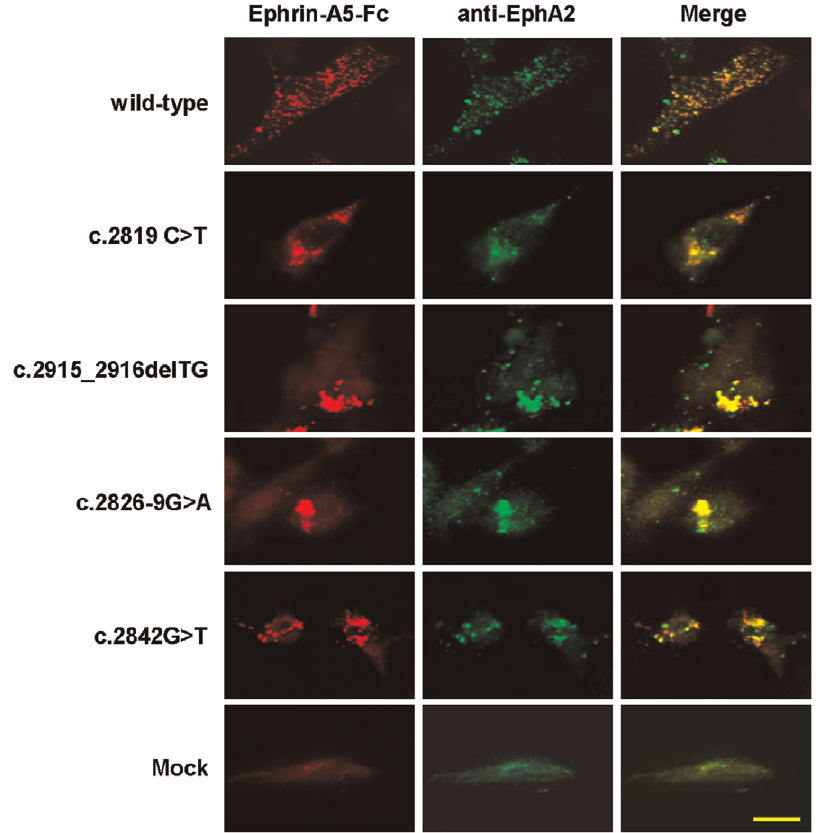
Figure 2. Subcellular localization of the wild-type and mutant EPHA2 receptors on transfected EphA2 2 / 2 MEF (E13.5) cells. EphA2 knockout MEF cells expressing wild-type or mutant EPHA2 were incubated with clustered ephrin-A5-Fc before fixation and treated with anti-Fc antibodies (red). After washing with PBS, cells were counterstained with anti-EphA2 antibody (green). Images were captured using a Nikon Eclipse C1 confocal microscope. Scale bar, 50 m m.